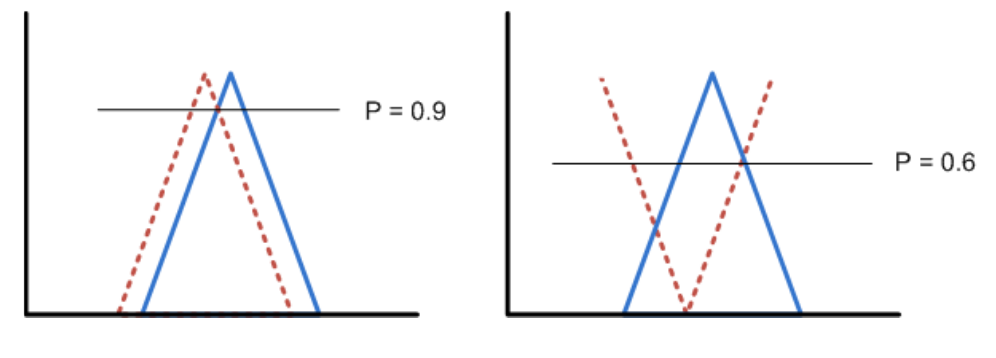
Figure 8. Possibility calculation. The straight line represents the expected fuzzy fact and the dotted line the provided fuzzy